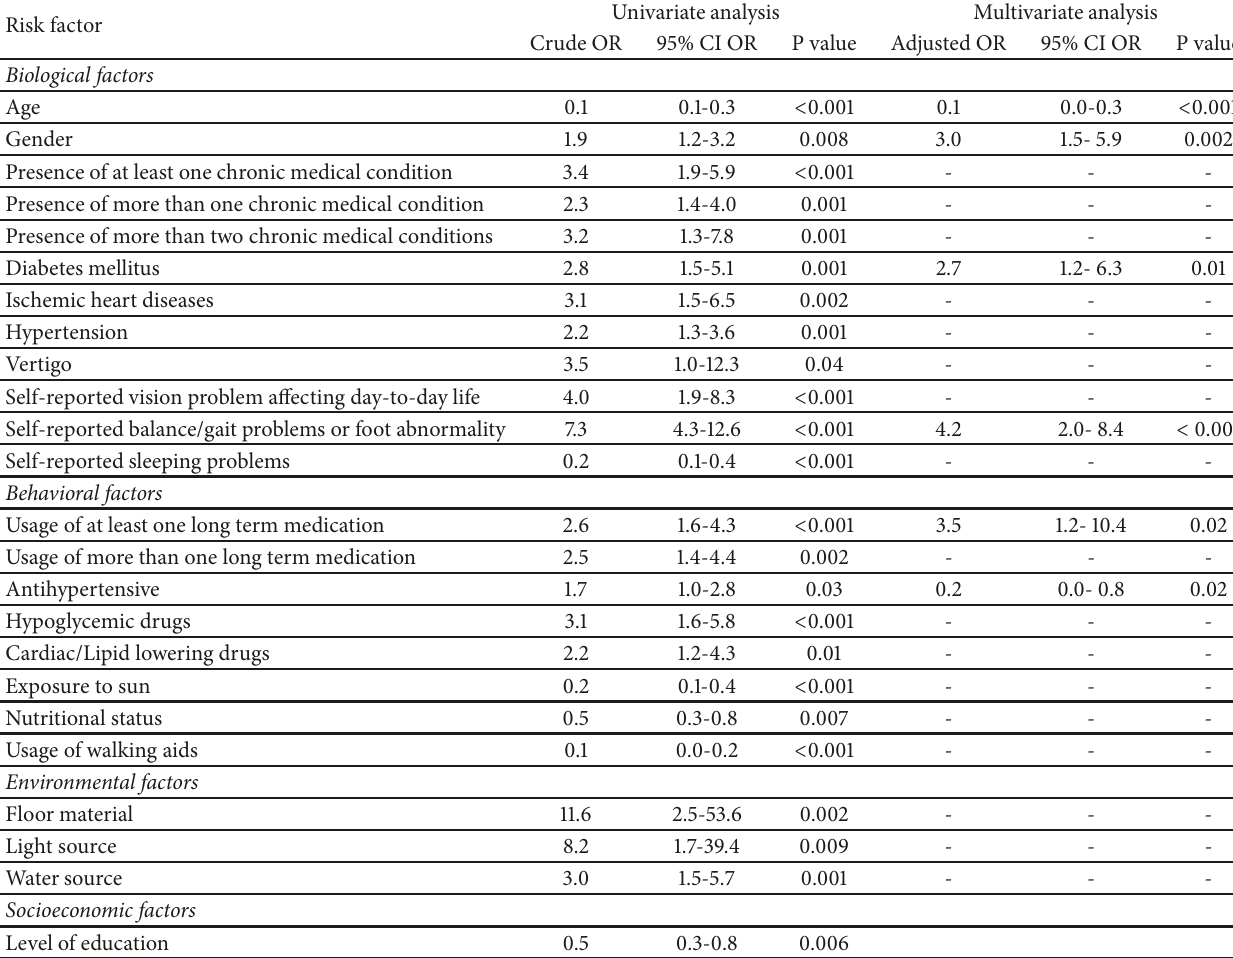
Table 5: Logistic regression analysis of risk factors for falls